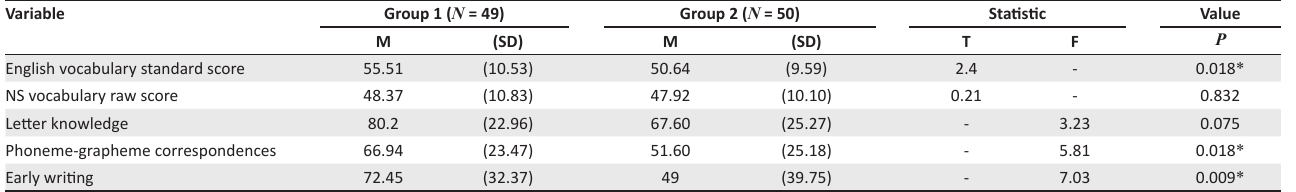
TABLE 1: Mean standardised score for English receptive vocabulary , Mean raw score for NS receptive vocabulary , and Mean percentages for Letter knowledge , Phoneme- Grapheme correspondences and Early Writing .